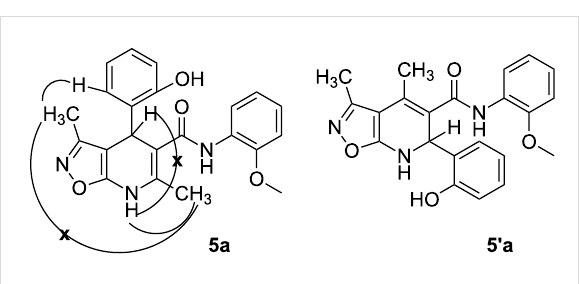
Figure 2: Alternative structures 5a and 5'a for dihydroisoxazolo- pyridine 5a and selected NOESY